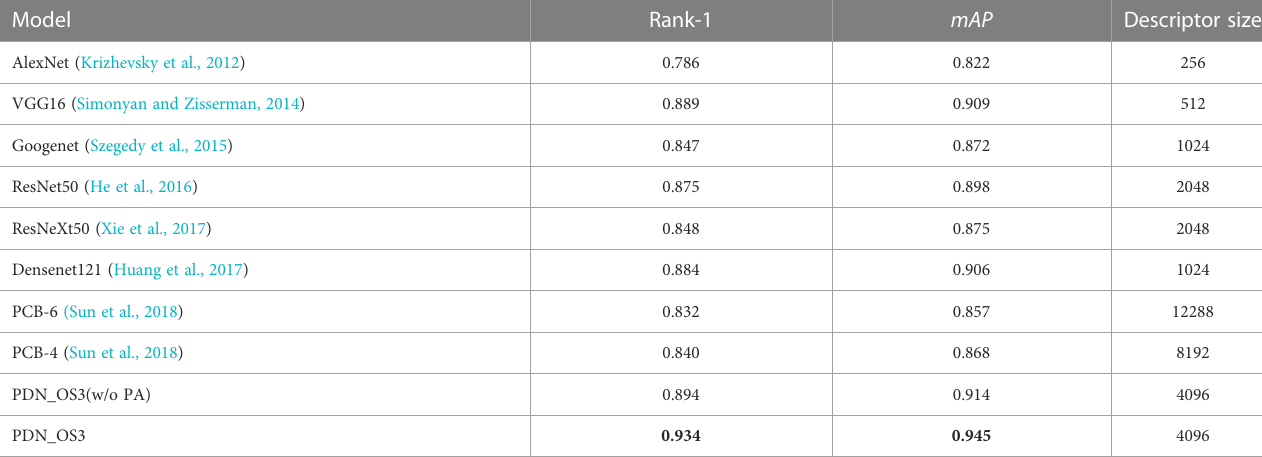
TABLE 2 Performance comparison on the Crab-146 dataset.